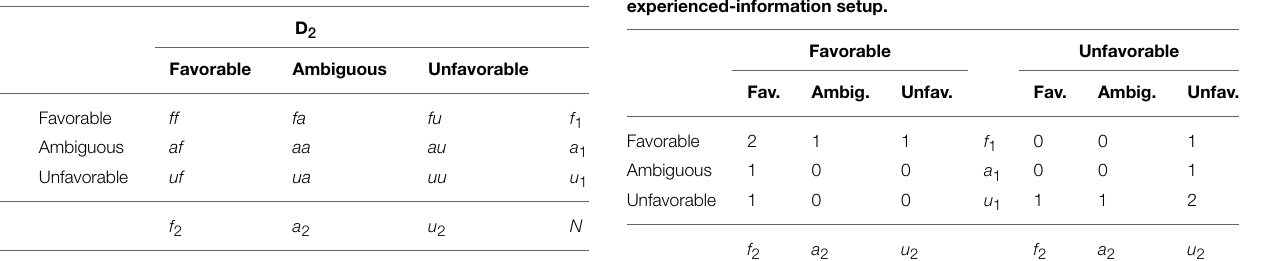
TABLE 2 | General conflict-ambiguity from experience setup.